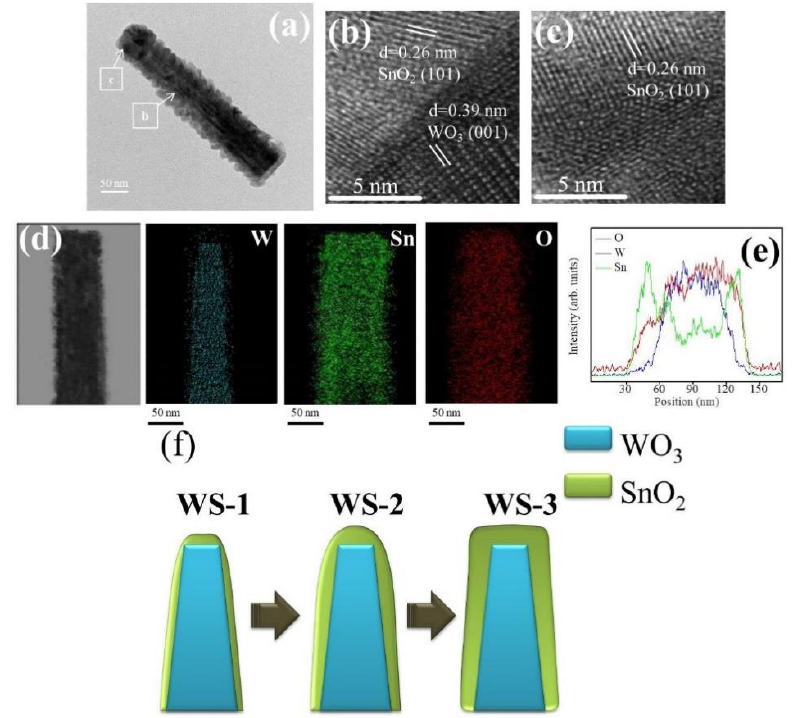
Figure 5. ( a ) Low magnification TEM image of a WS-3 nanorod. ( b , c ) HRTEM images of the nanorod taken from different regions. ( d ) W, Sn, and O elemental mapping images of the nanorod. ( e ) EDS line-scanning profiles across the nanorod. ( f ) Schematics of the WS-1, WS-2, and WS-3 nanorods.